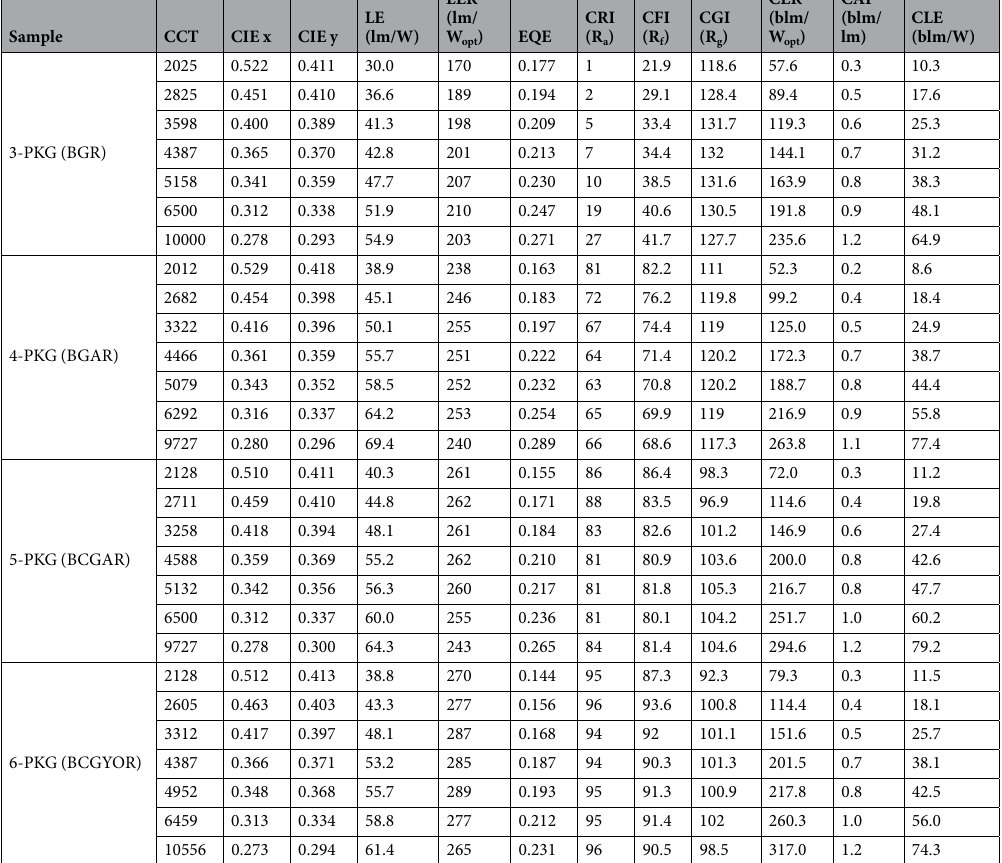
Table 1. Optical properties of the three- to six-package white